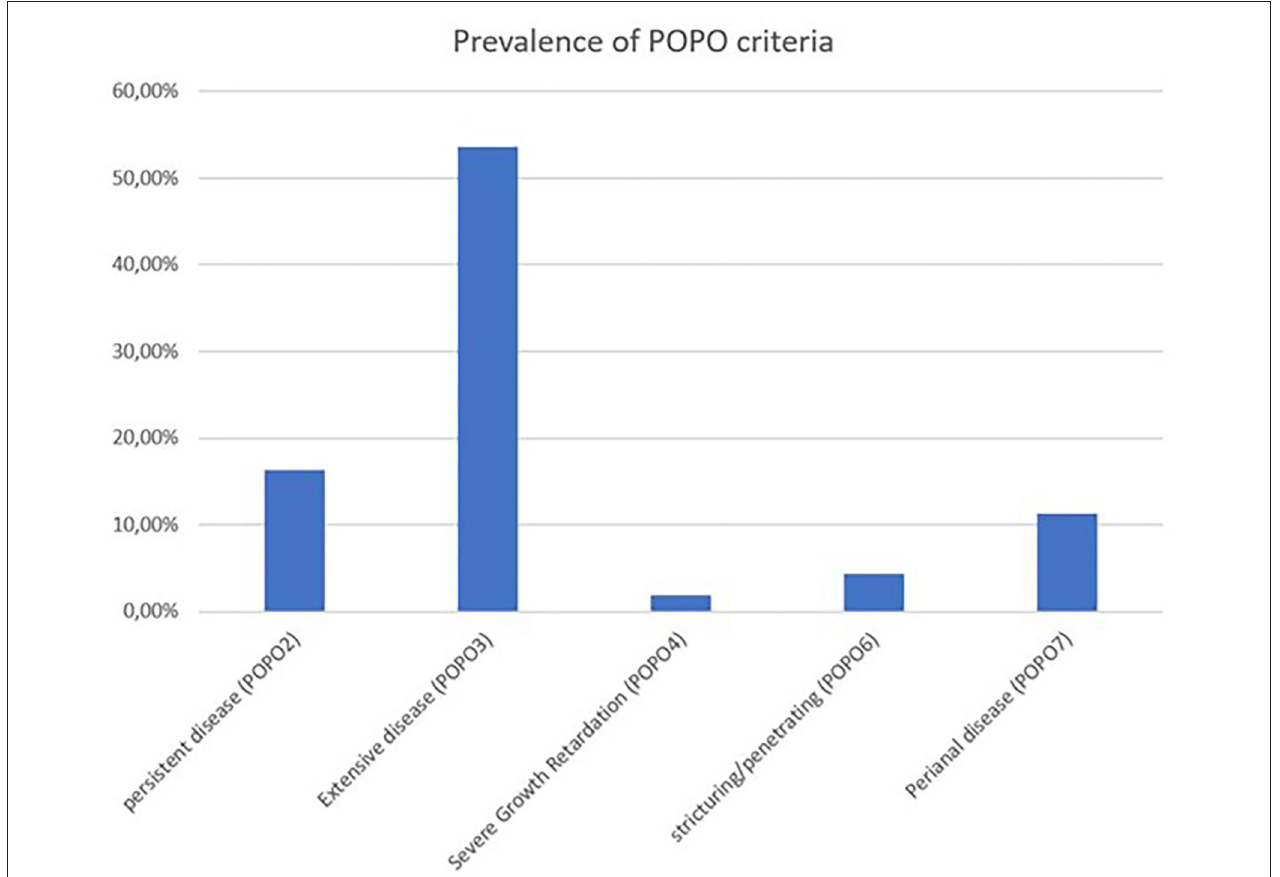
FIGURE 2 | Prevalence of POPO criteria. Prevalence of POPO criteria at initial diagnosis of paediatric CD patients from CEDATA GPGE registry.